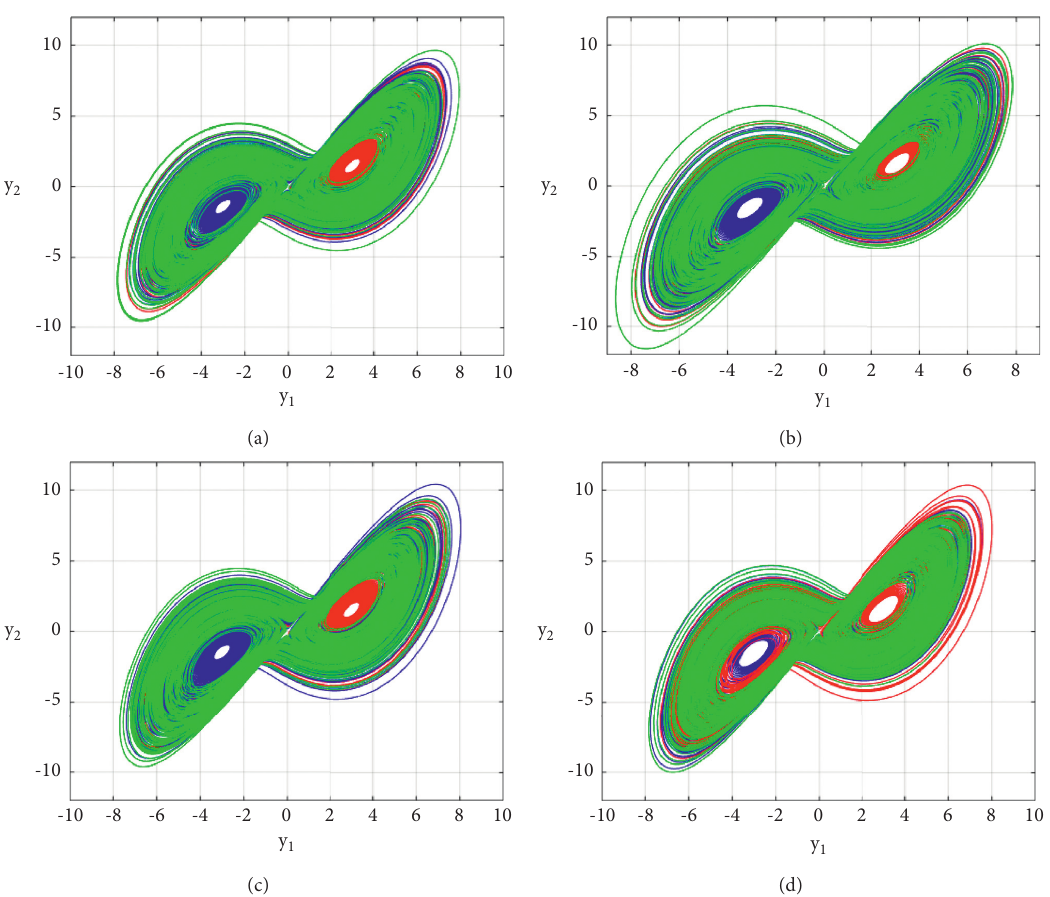
Figure 7: The projection of the self-excited attractor of the fractional-order Matouk’s system in the y ( 0 . 1 , 0 , 1 , 0 . 01 ) for green trajectory; ( 3 , 1 , 15 , 0 . 0199 ) for red trajectory; and (− 3 , − 1 , 15 , 0 . 0199 ) for blue trajectory and using the following parameter values: (a) a � − 3 . 2 , b � 15 ,c � 0 . 6 ,d � − 0 . 0001 ,h � − 1 . 5 , α � 0 . 77 ; (b) a � − 3 , b � 15 . 75 ,c � 0 . 6 ,d � − 0 . 0001 ,h � − 1 . 5 , α � 0 . 77 ;